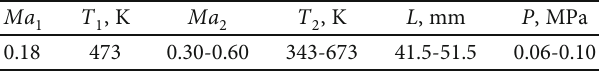
Figure 2: Experimental setups for combustion. Table 1: Summary of experimental